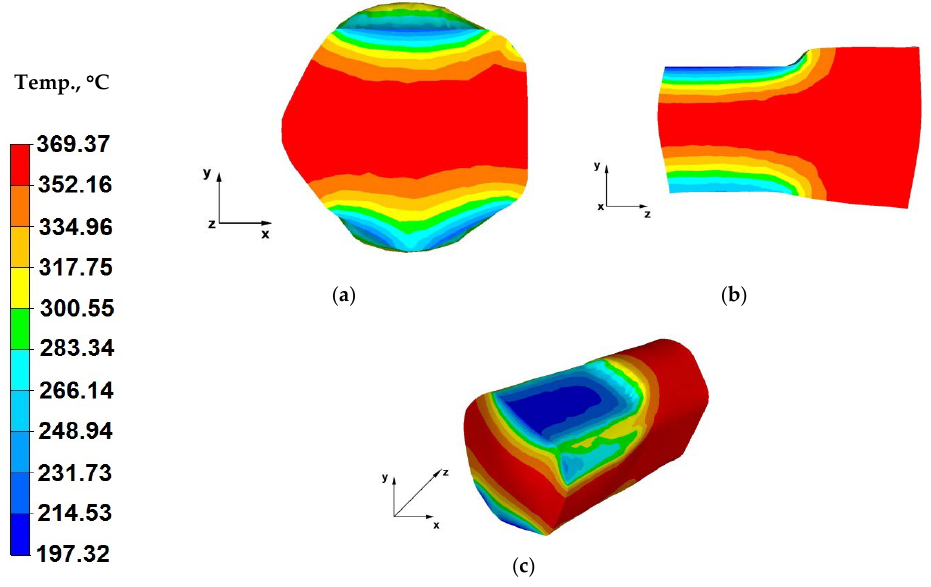
Figure 13. ( a ) Temperature distribution over the cross-section of an AZ91 alloy forging deformed within the third pass, with a relative reduction of 40%, in trapezoid-rhombic dies, after a 90° turning of the forging; ( b ) Temperature distribution over the longitudinal-section of an AZ91 alloy forging deformed within the third pass, with a relative reduction of 40%, in trapezoid-rhombic dies, after a 90° turning of the forging; ( c ) Axonometric view of the temperature distribution over the surface of an AZ91 alloy forged within the third forging pass, with a relative reduction of 40%, in trapezoid-rhombic dies, after a 90° turning of the forging.